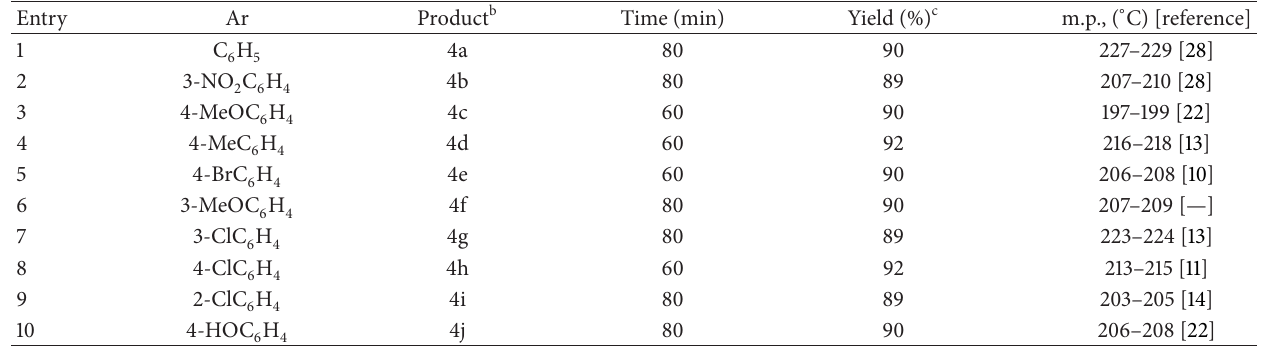
Table 2: Synthesis of tetrahydrobenzo[ b ]pyrans using pentafluoropropionic acid as catalyst a .